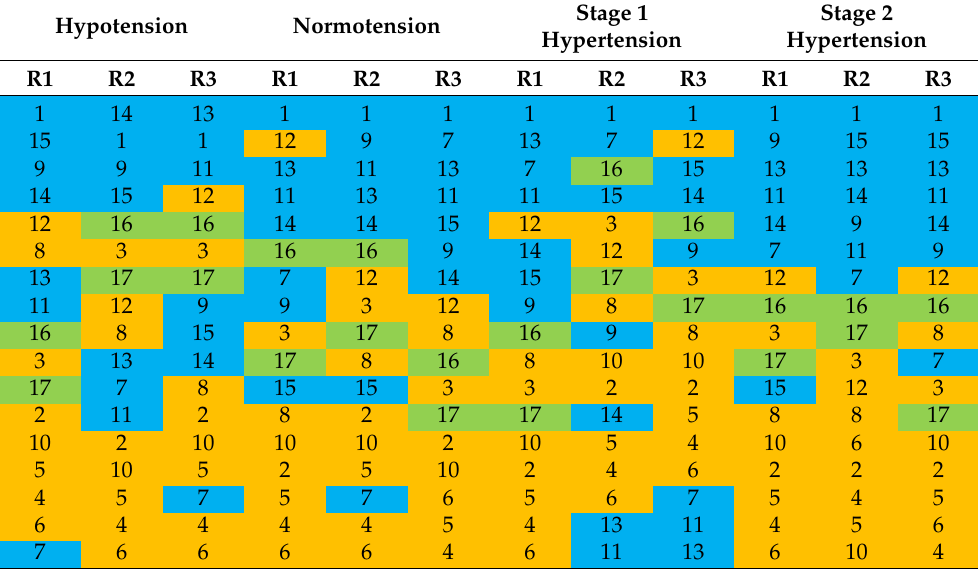
Table 6. Ordered features from the lowest | ρ | to the highest | ρ | for features (1 to 17) extracted from red PPG signals, in each of the runs of the experiment (R#) and under each blood pressure condition. Features coloured blue indicate temporal features, features coloured yellow indicate amplitude features, and those in green are geometric features reported in